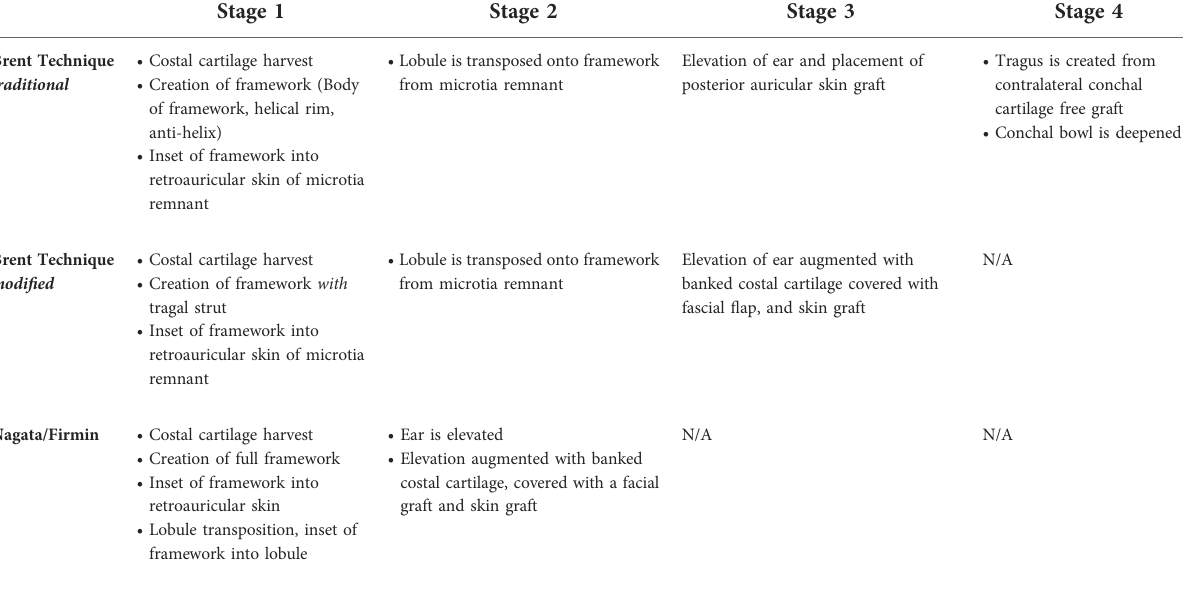
TABLE 4 Stages of common autologous cartilage reconstructive